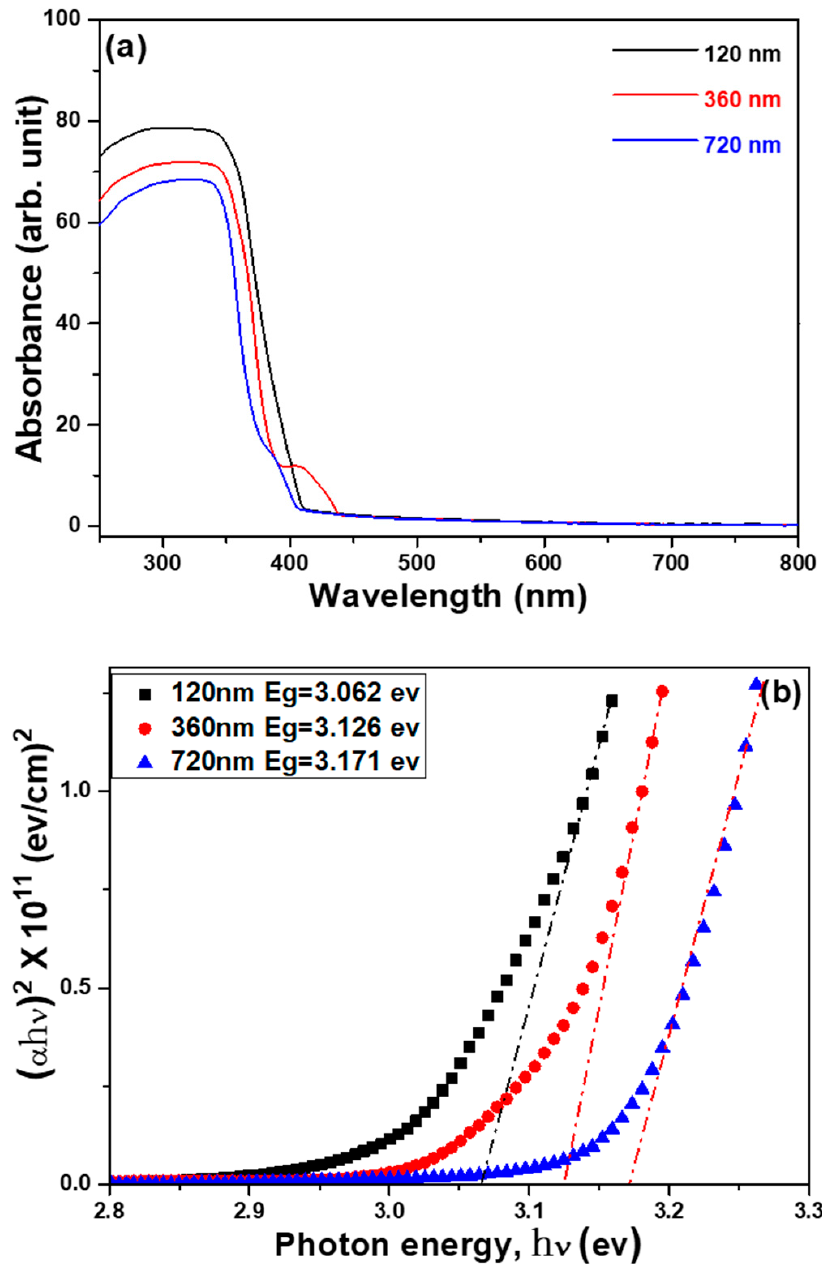
Figure 12. ( a ) UV-visible absorption spectra and ( b ) Tauc plots from UV-visible absorption spec- Figure 12. ( a ) UV ‐ visible absorption spectra and ( b ) Tauc plots from UV ‐ visible absorption spectros ‐ troscopy of the ZnO nanoflower arrays using different copy of the ZnO nanoflower arrays using different substrates.